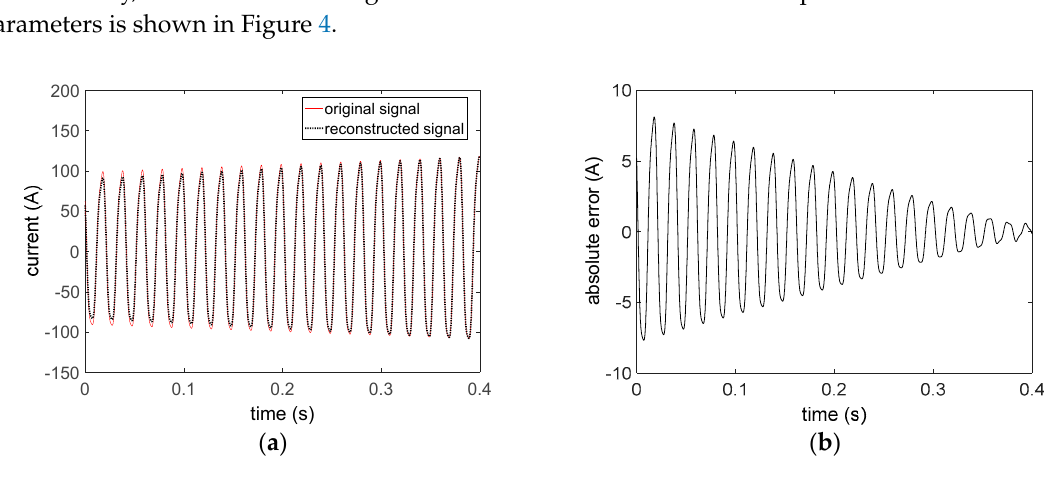
Figure 4. Simulation results of WIFFT and envelope parameters estimation method: ( a ) Comparison of original signal and reconstructed signal; ( b ) Absolute error of original signal and reconstructed signal.